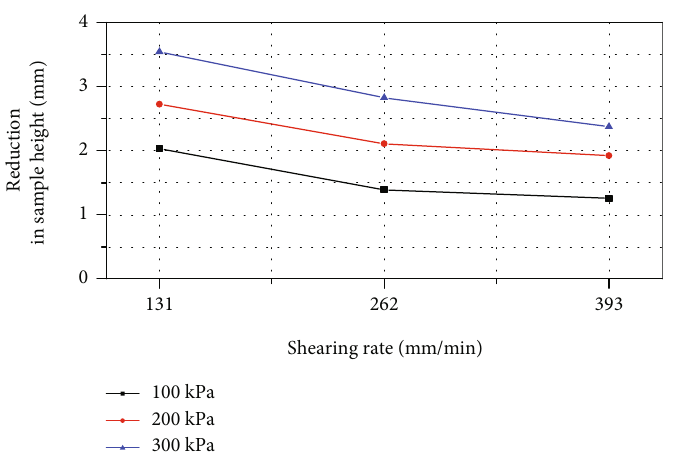
Figure 8: Shearing rate versus reduction in sample height after the shear was stopped.